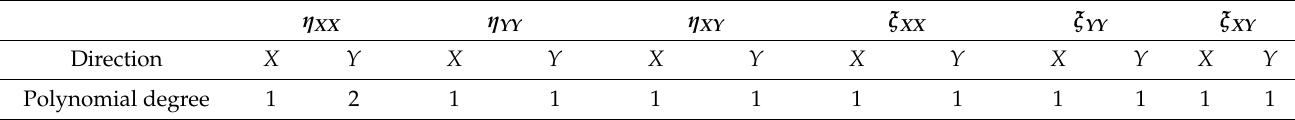
Figure 6. Traction: normalized membrane strain 𝜂 (cid:3025)(cid:3025) pre-extrapolation.